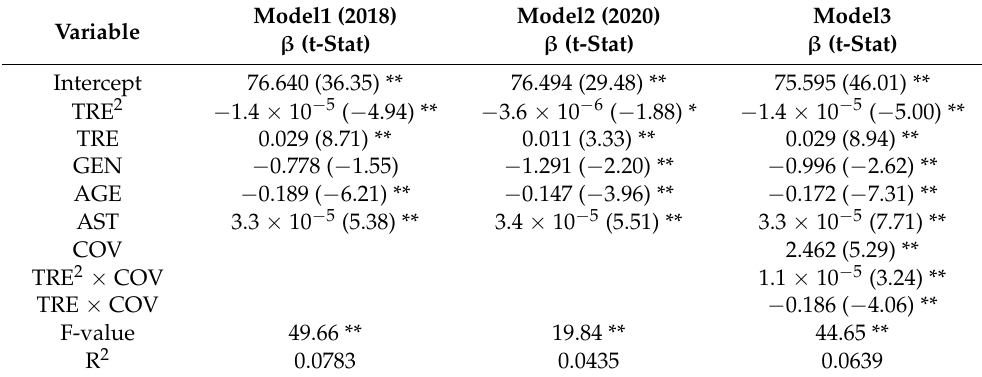
Table 4. Results of hypotheses